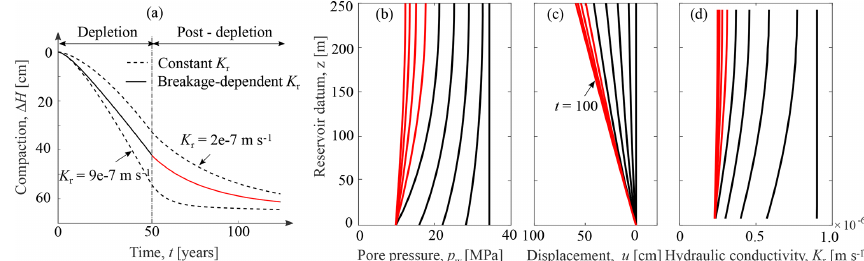
Figure 3. Simulations of a single reservoir compaction during and after depletion: (a) time history of reservoir compaction; (b, c) 25-year isocrones of the nodal pore pressure and displacement; (d) 25-year isocrones of hydraulic conductivity at gauss